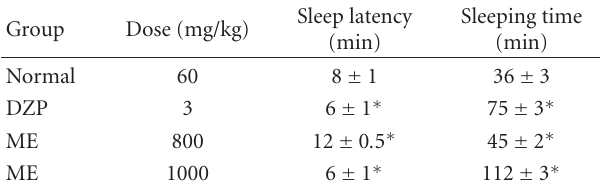
Table 3: E ff ect of the methanolic extract of Lavandula o ffi cinalis on the onset and duration of sleep in thiopental-treated mice. Mice received thiopental (60mg/kg, i.p.) 30min after the pretreatment of methanolic extract (800 and 1000 mg/kg, p.o.) and diazepam (3mg/kg, i.p.). i.p. means intraperitoneal route; p.o. means oral route; ( n = 5) means number of mice per group; ME means methanolic extract; D ZP means diazepam. Data are expressed as mean ± SD; P < 0 . 001 versus the control